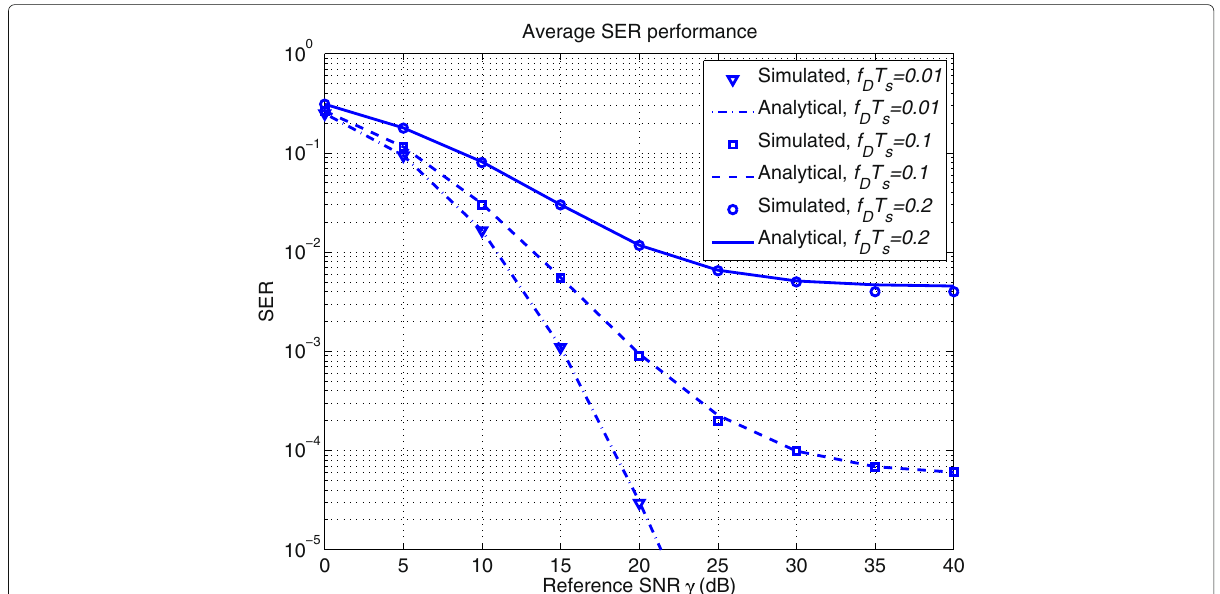
Fig. 6 Average SER for systems different maximum normalized Doppler spread ( N = 4 and x =